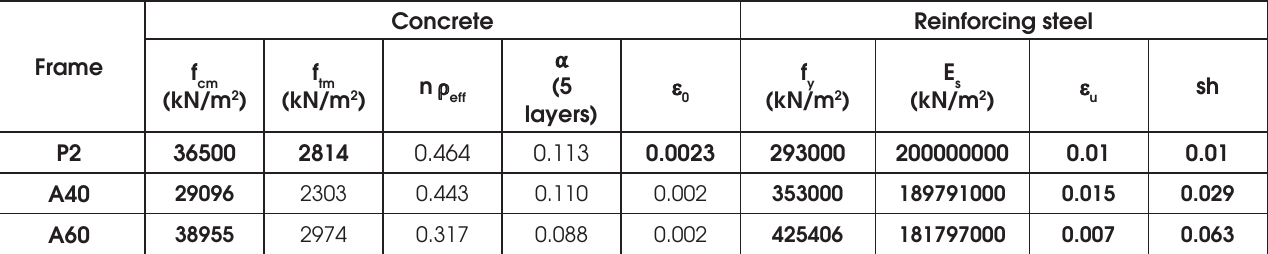
Material properties used in numerical analysis of frames (experimental values in bold, calculated or estimated values without bold)